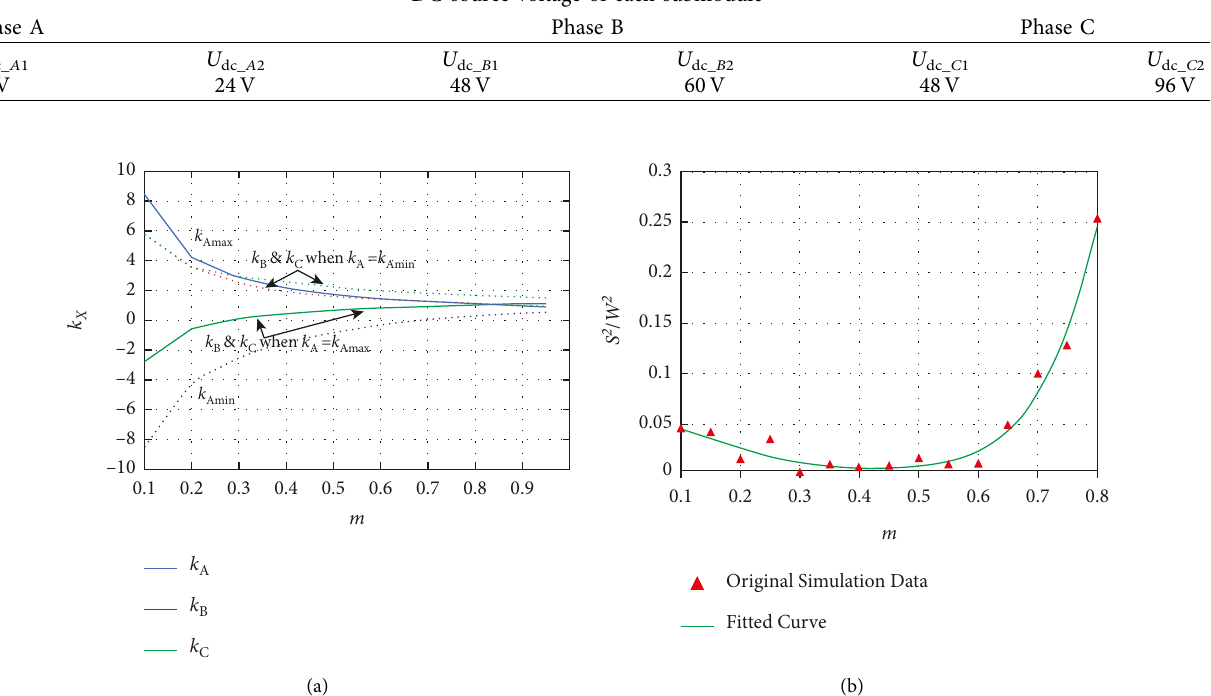
Figure 2: Control performance of output power generation when r and k A max/min and (b) trend of three-phase variance S 2 with m.